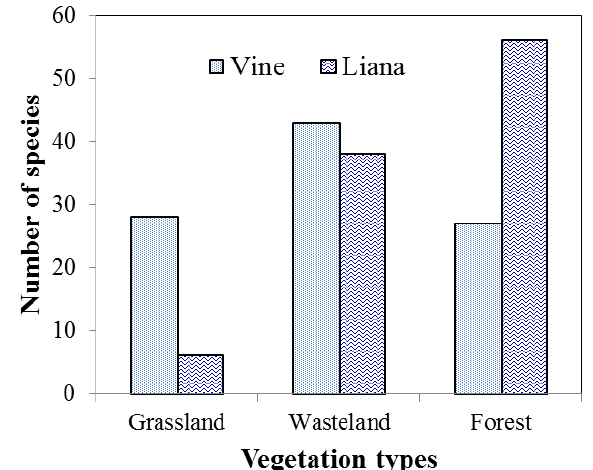
Fig. 1. Number of vines and lianas within different vegetation types